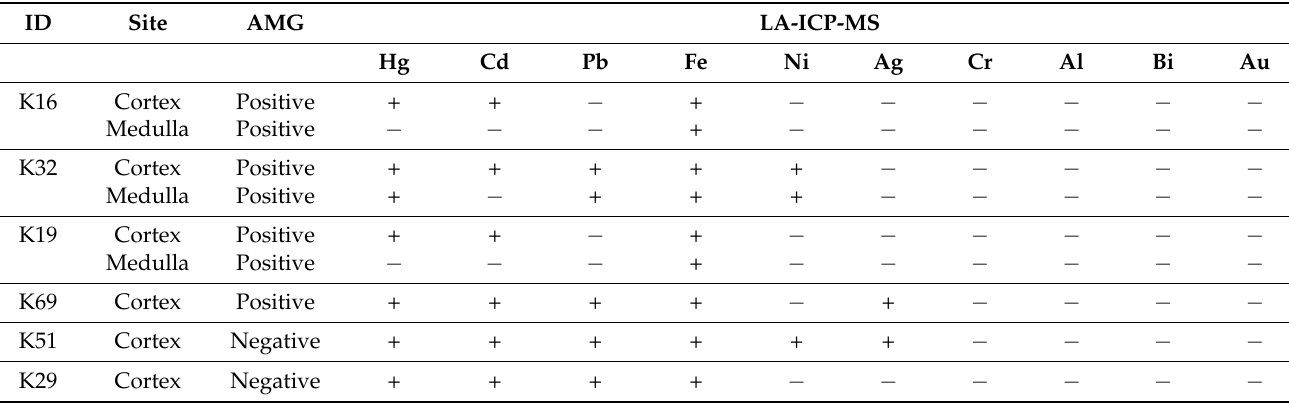
Cortex Positive + + + + − + − − − − Negative + + + + + + − − − − Cortex Negative + + + + − − − − − − AMG autometallography, ID identity number, + detected, − not detected, K identity number (see Table